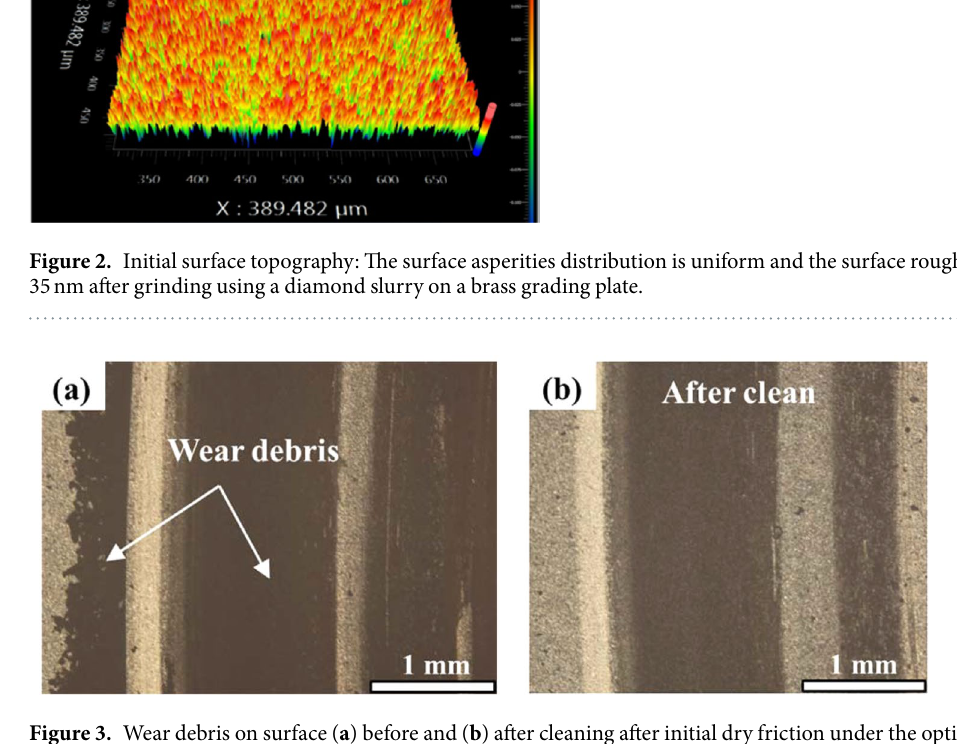
Figure 3. Wear debris on surface ( a ) before and ( b ) after cleaning after initial dry friction under the optical microscope.